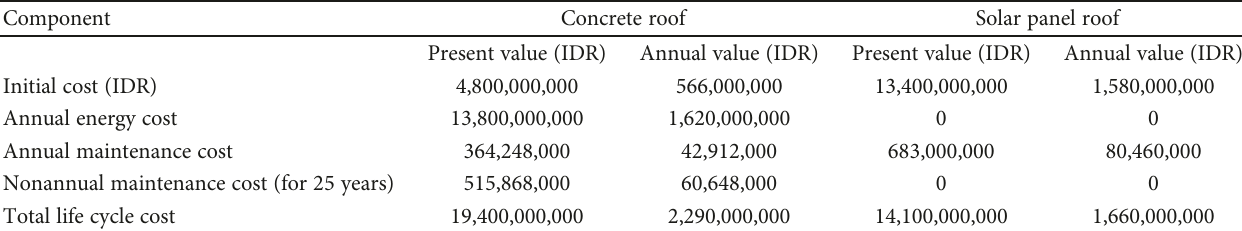
Table 4: Comparison of the present value and annual